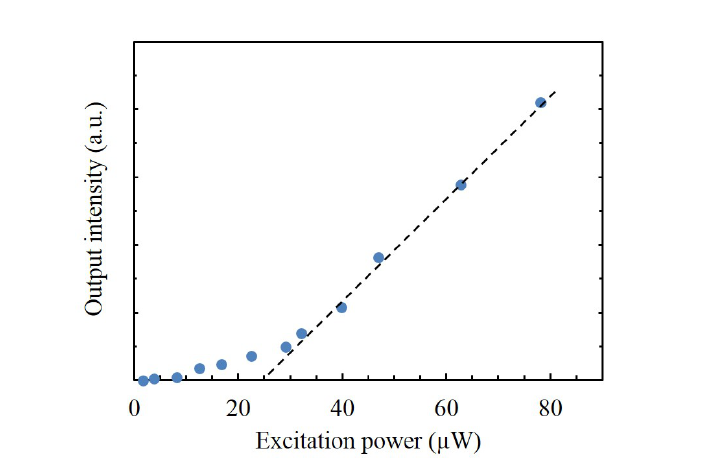
Figure 9. Output intensity as a function of excitation power for optically-driven CirD